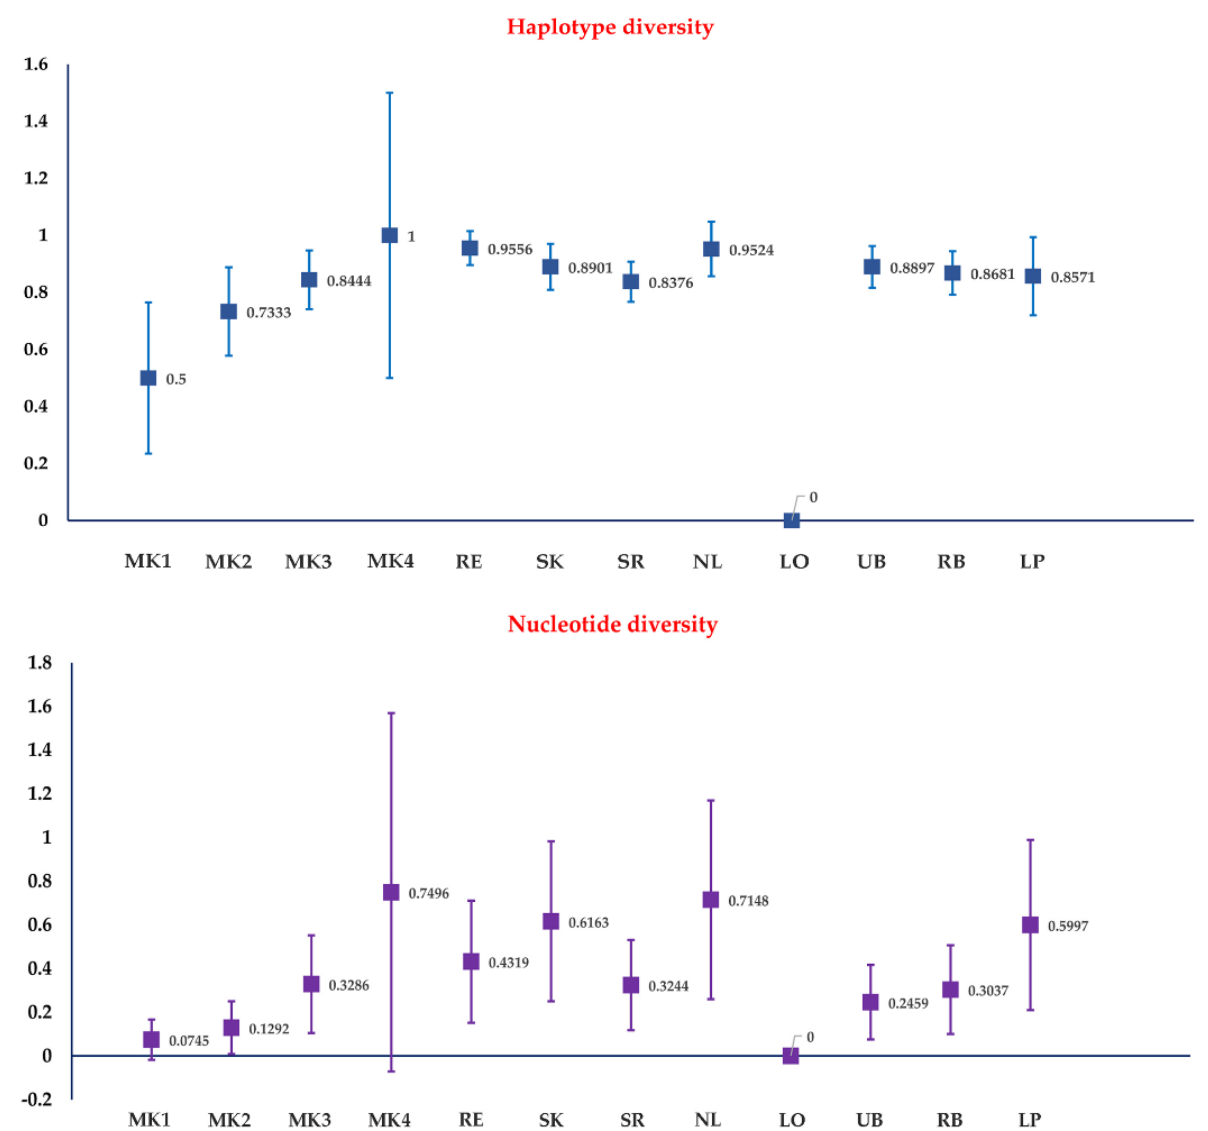
Figure 2. Haplotype diversity and percentage nucleotide diversity (±standard deviation) of 12 pop- ulations of Culicoides mahasarakhamense in